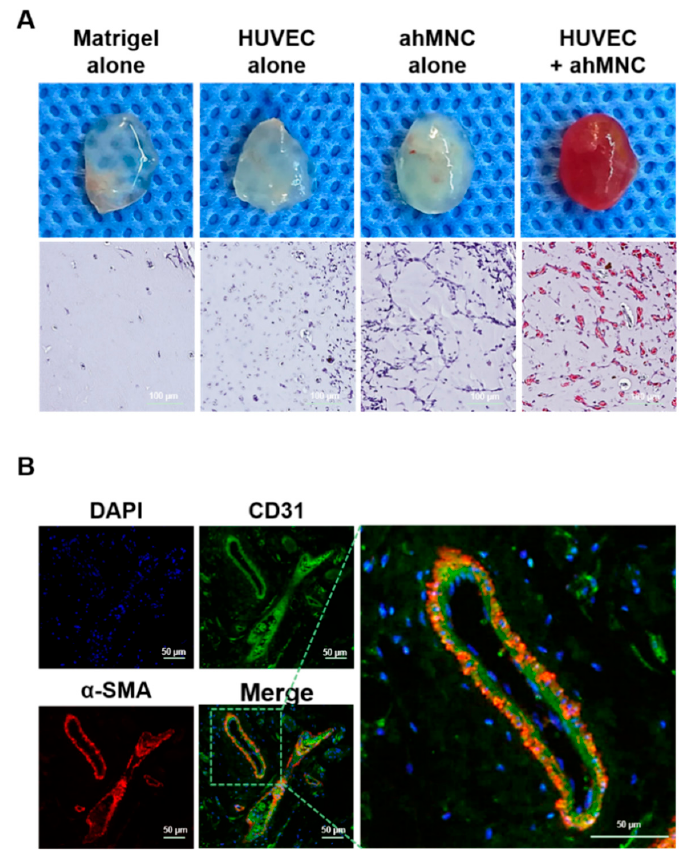
Figure 4. Angiogenic potential of ahMNCs-Clump II. ( A ) ahMNC-Clump II and/or HUVECs in Matrigel were injected into the subcutaneous tissue of immunodeficient mice. At 4 days after injection, Matrigels were retrieved and examined histologically. Scale bar = 100 µm. ( B ) Endothelial cells and pericytes were visualized by immunofluorescence for CD31 and α SMA, respectively. Scale bar = 50 µm.